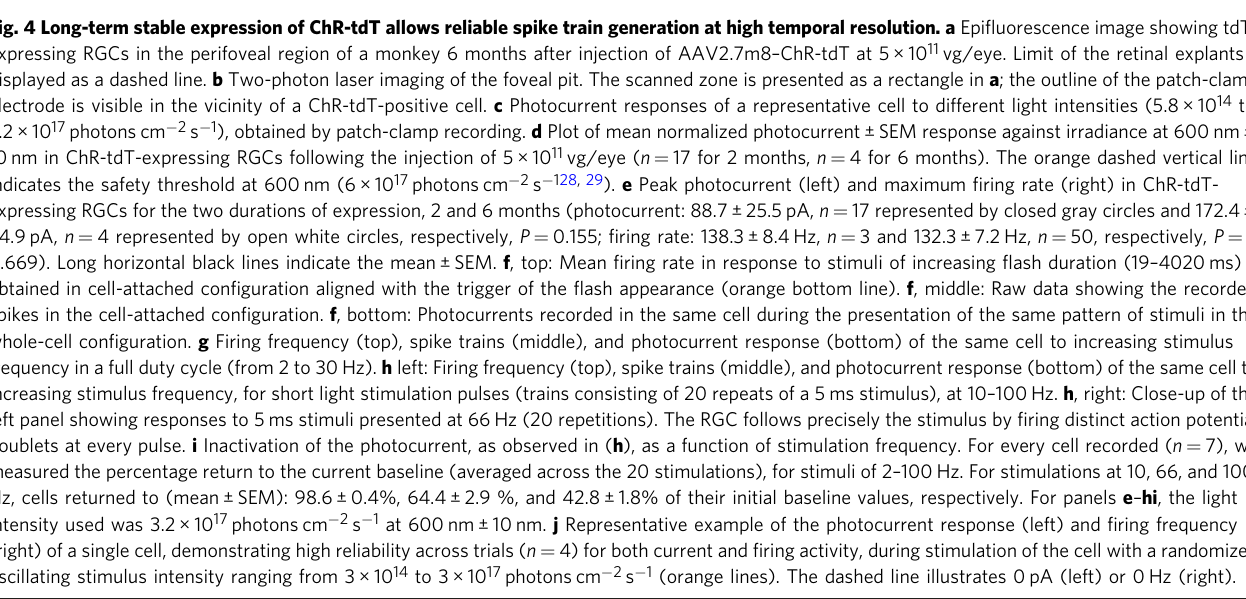
Fig. 4 Long-term stable expression of ChR-tdT allows reliable spike train generation at high temporal resolution. a Epi fl uorescence image showing tdT- expressing RGCs in the perifoveal region of a monkey 6 months after injection of AAV2.7m8 – ChR-tdT at 5 × 10 11 vg/eye. Limit of the retinal explants displayed as a dashed line. b Two-photon laser imaging of the foveal pit. The scanned zone is presented as a rectangle in a ; the outline of the patch-clamp electrode is visible in the vicinity of a ChR-tdT-positive cell. c Photocurrent responses of a representative cell to different light intensities (5.8 × 10 14 to 3.2 × 10 17 photons cm − 2 s − 1 ), obtained by patch-clamp recording. d Plot of mean normalized photocurrent ± SEM response against irradiance at 600 nm ± 10 nm in ChR-tdT-expressing RGCs following the injection of 5 × 10 11 vg/eye ( n = 17 for 2 months, n = 4 for 6 months). The orange dashed vertical line indicates the safety threshold at 600 nm (6 × 10 17 photons cm − 2 s − 128, 29 ). e Peak photocurrent (left) and maximum fi ring rate (right) in ChR-tdT- expressing RGCs for the two durations of expression, 2 and 6 months (photocurrent: 88.7 ± 25.5 pA, n = 17 represented by closed gray circles and 172.4 ± 74.9 pA, n = 4 represented by open white circles, respectively, P = 0.155; fi ring rate: 138.3 ± 8.4 Hz, n = 3 and 132.3 ± 7.2 Hz, n = 50, respectively, P = 0.669). Long horizontal black lines indicate the mean ± SEM. f , top: Mean fi ring rate in response to stimuli of increasing fl ash duration (19 – 4020 ms) obtained in cell-attached con fi guration aligned with the trigger of the fl ash appearance (orange bottom line). f , middle: Raw data showing the recorded spikes in the cell-attached con fi guration. f , bottom: Photocurrents recorded in the same cell during the presentation of the same pattern of stimuli in the whole-cell con fi guration. g Firing frequency (top), spike trains (middle), and photocurrent response (bottom) of the same cell to increasing stimulus frequency in a full duty cycle (from 2 to 30 Hz). h left: Firing frequency (top), spike trains (middle), and photocurrent response (bottom) of the same cell to increasing stimulus frequency, for short light stimulation pulses (trains consisting of 20 repeats of a 5 ms stimulus), at 10 – 100 Hz. h , right: Close-up of the left panel showing responses to 5 ms stimuli presented at 66 Hz (20 repetitions). The RGC follows precisely the stimulus by fi ring distinct action potential doublets at every pulse. i Inactivation of the photocurrent, as observed in ( h ), as a function of stimulation frequency. For every cell recorded ( n = 7), we measured the percentage return to the current baseline (averaged across the 20 stimulations), for stimuli of 2 – 100 Hz. For stimulations at 10, 66, and 100 Hz, cells returned to (mean ± SEM): 98.6 ± 0.4%, 64.4 ± 2.9 %, and 42.8 ± 1.8% of their initial baseline values, respectively. For panels e – hi , the light intensity used was 3.2 × 10 17 photons cm − 2 s − 1 at 600 nm ± 10 nm. j Representative example of the photocurrent response (left) and fi ring frequency (right) of a single cell, demonstrating high reliability across trials ( n = 4) for both current and fi ring activity, during stimulation of the cell with a